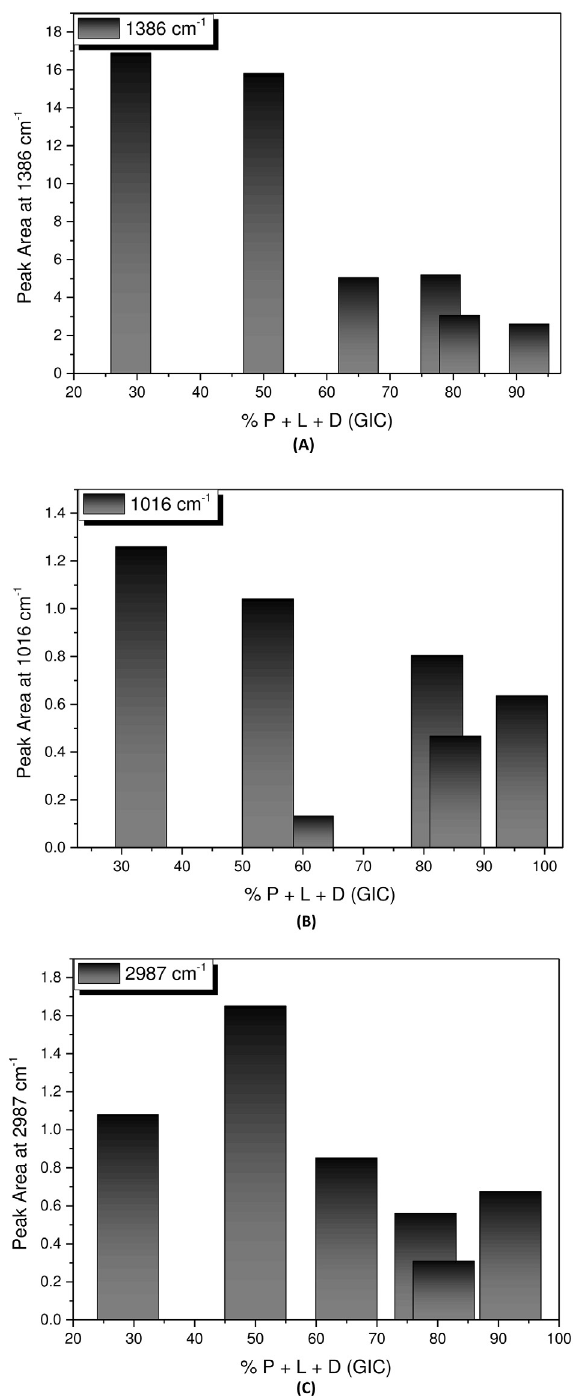
Figure 7- A: Variation of the band area at 1386 cm -1 ; B: Variation of the band area at 1016 cm -1 ; C: Variation of the band area at